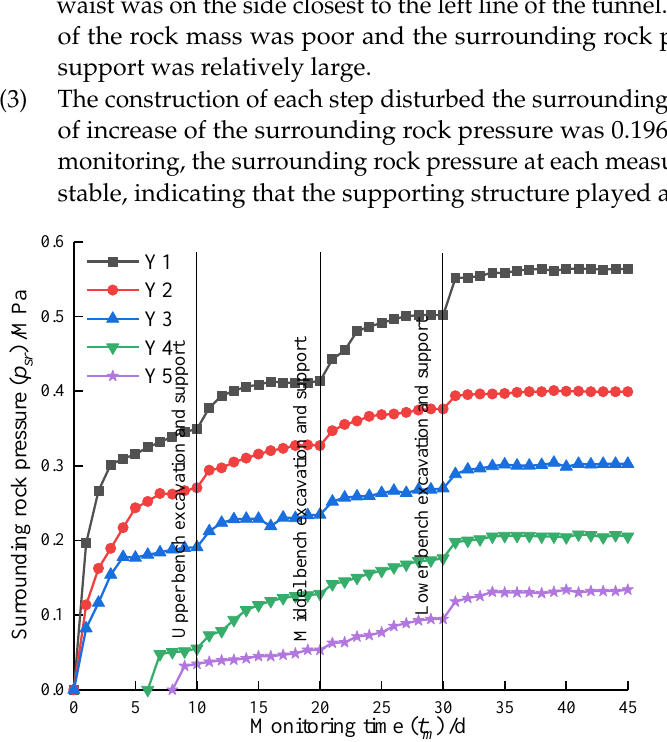
Figure 12. Time history curves of the stress of the surrounding rock at YK58 + 570 (in 2020).